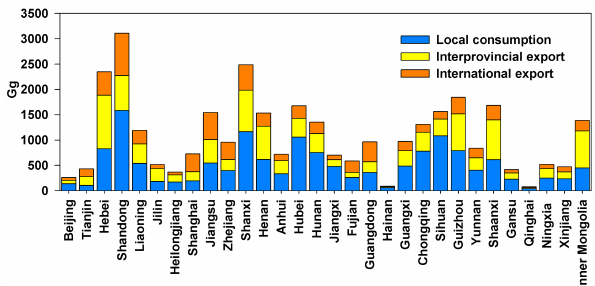
Figure 1. Production-based SO 2 emissions in 2007 by province and consumption